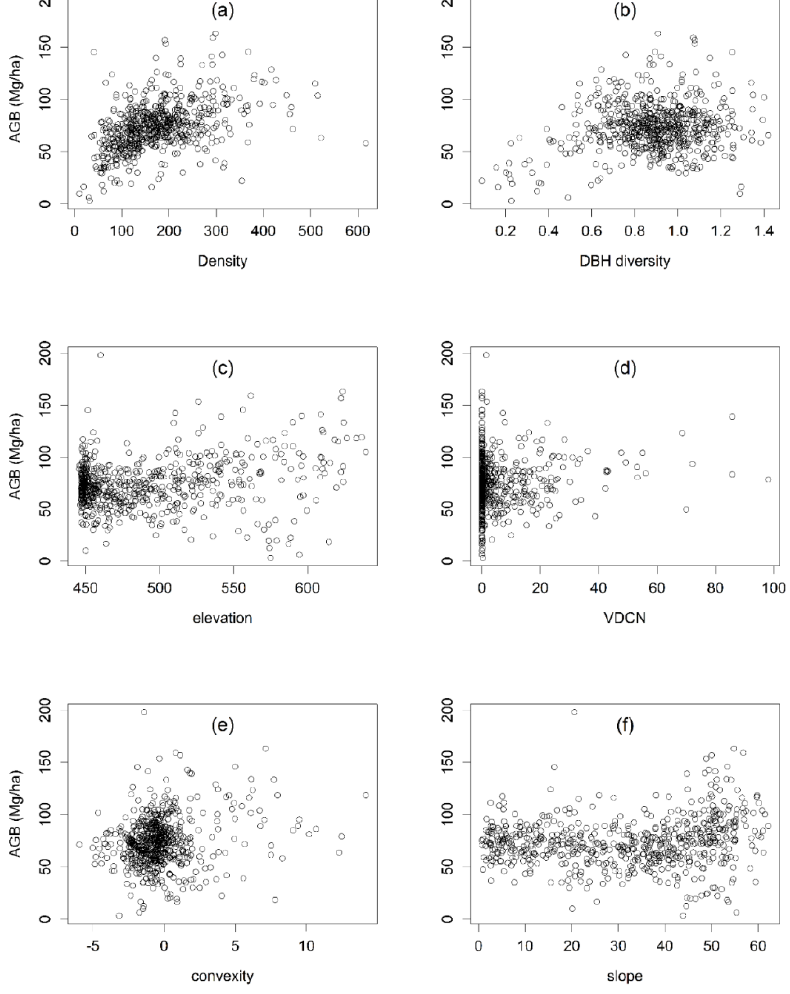
Figure 6. Scatter plots demonstrating relationships between AGB and six significant predictors ( a ), diameter at breast height (DBH) diversity ( b ), elevation ( c ), vertical distance to channel network (density( a ), diameter at breast height ( DBH) diversity ( b ), elevation ( c ), vertical distance to (VDCN) ( d ), convexity ( e ), and slope( f channel network ( VDCN) ( d ), convexity ( e ), and slope( f )).